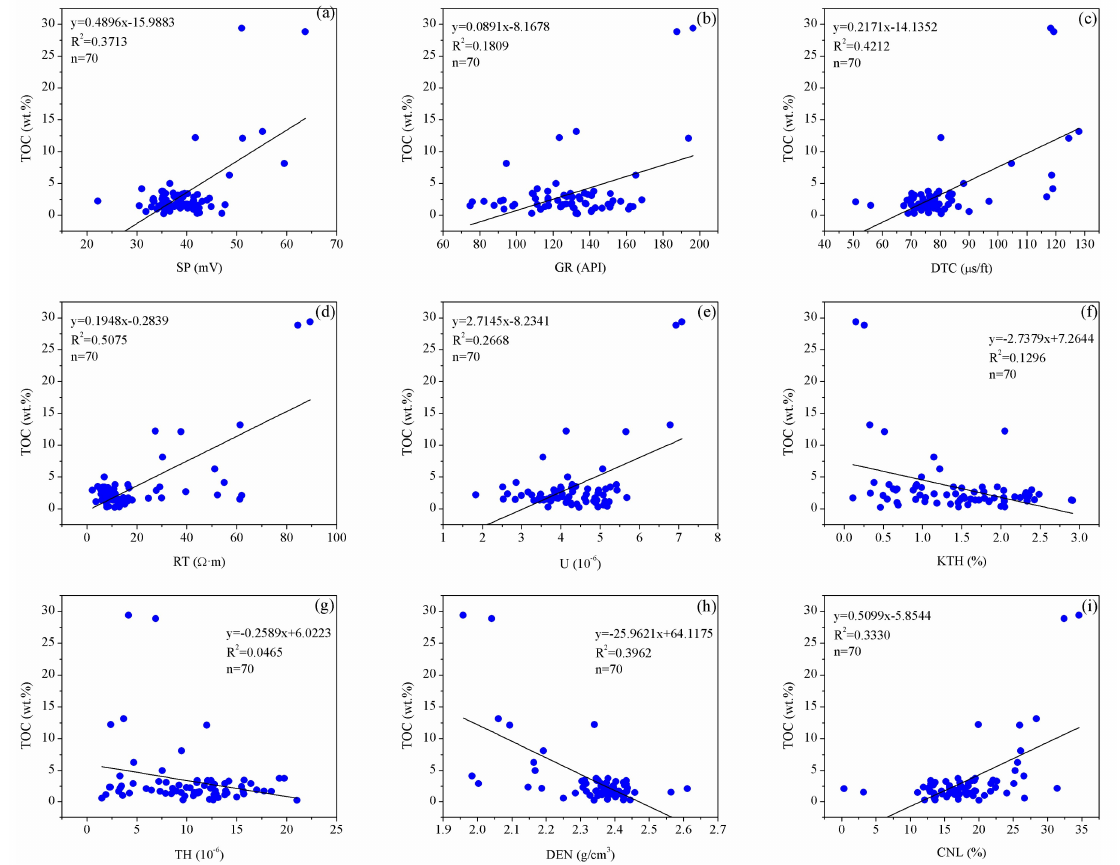
Figure 4. Cross-plots of TOC laboratory-measurements and logging data for Well E1 ( a ) SP-TOC, ( b ) GR-TOC, ( c ) DTC-TOC, ( d ) RT-TOC, ( e ) U-TOC, ( f ) KTH-TOC, ( g ) TH-TOC, ( h ) DEN-TOC, and ( i ) CNL-TOC; R 2 = coefficients of determination; n = number of sample